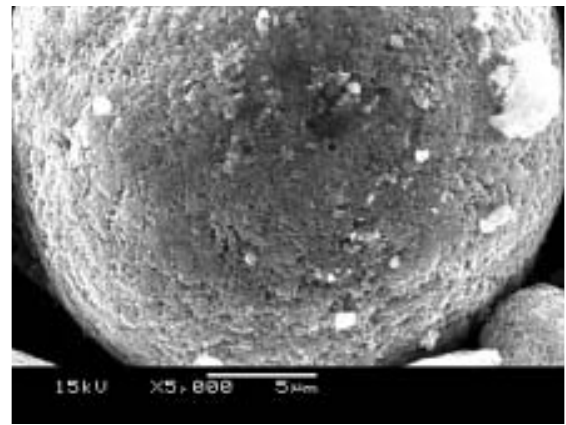
particlesa) Muskmelon-like substance-coated TiO 2